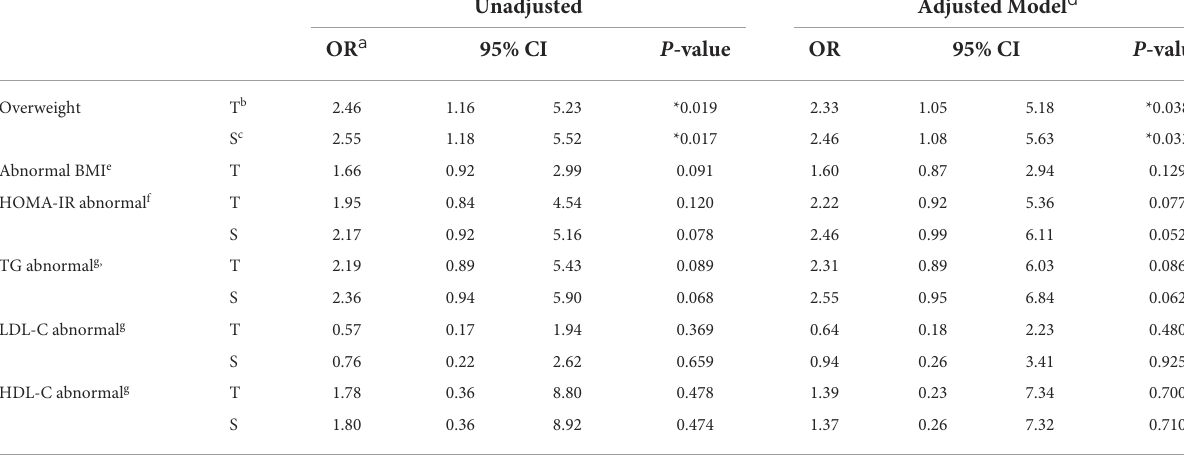
TABLE 5 Logistic regression for associations between maternal shift work during pregnancy and health outcome of children at 7-year-old follow-up. Unadjusted Adjusted Model d OR a 95% CI P -value OR 95% CI P -value Overweight T b